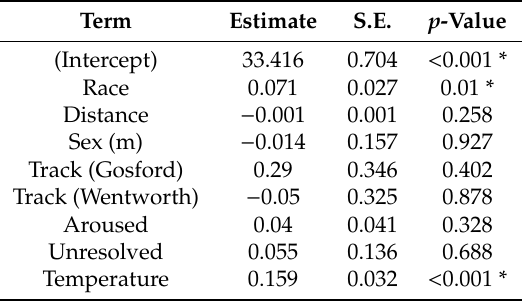
Figure 5. Predicted Eye Temp Before races depending on race number. Eye Temp Before races increases as race number increases, indicating greyhounds become increasingly aroused as the race meet progresses. 95% confidence intervals shown with shading. Ticks on the x-axis give an indication of n for each race number. Table 7. Generalised linear model summary for Eye Temp After races. Ambient temperature (Celsius) and increasing race number both have significant, positive effects on Eye Temp After races. S.E. = standard error.